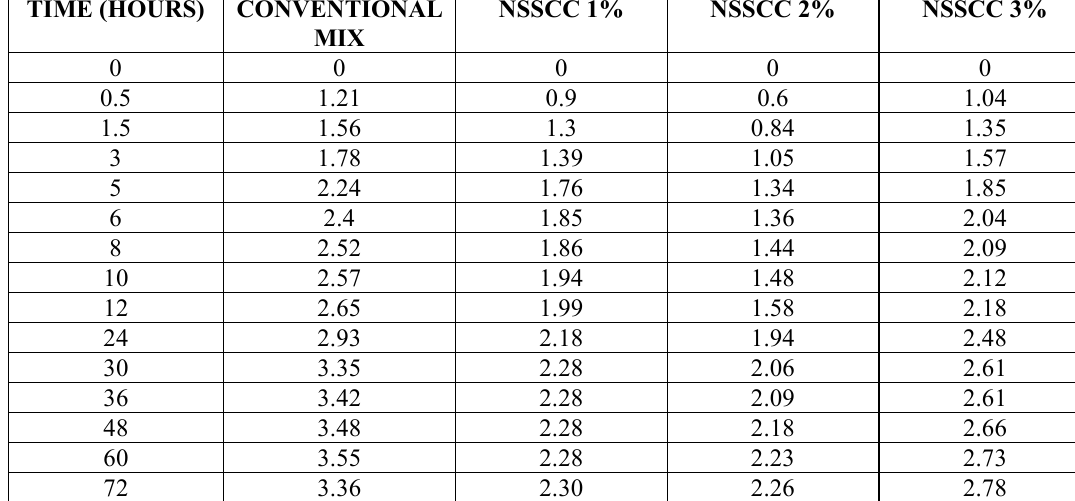
Percentage of Absorption values of Nano Silica. TIME (HOURS)